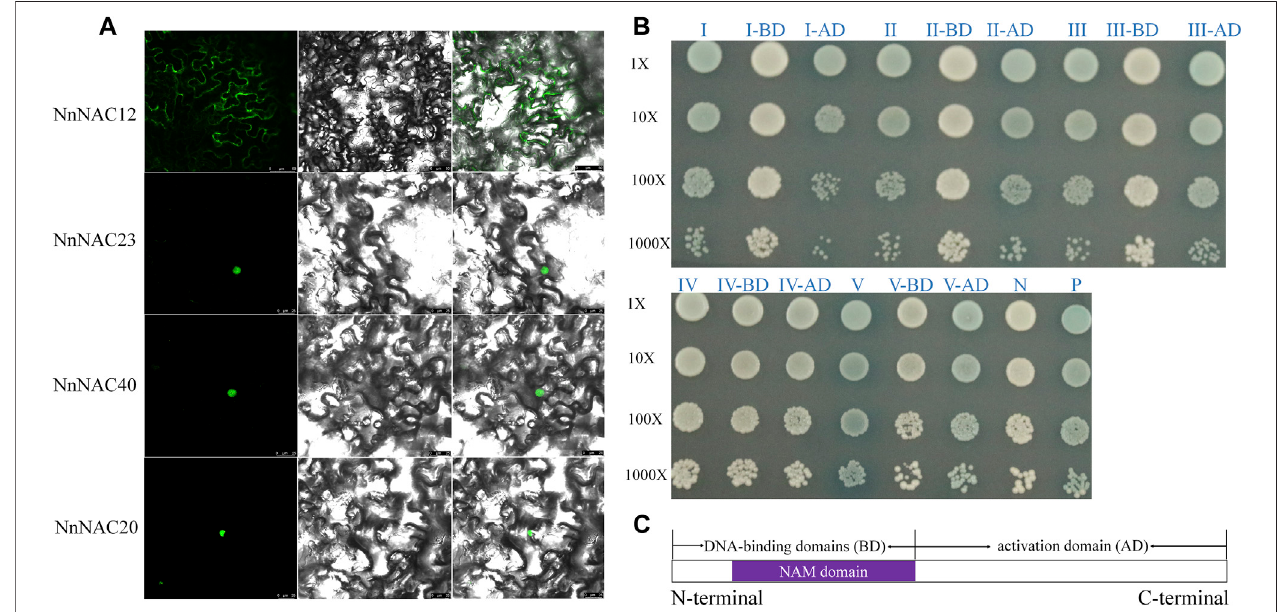
FIGURE 4 | Subcellular localization and transcriptional activation assay of NnNAC proteins. (A) Subcellular localization of four NnNAC proteins in tobacco leaves. (B) Transactivation assay of NnNAC proteins in the Y2H system. I: NnNAC12; II: NnNAC23; III: NnNAC20; IV: NnNAC52; V: NnNAC40; AD and BD represent NnNAC protein with AD and BD domains, respectively; P: positive control (pGBKT7-53); N: negative control. (C) Schematic representation of NnNAC protein